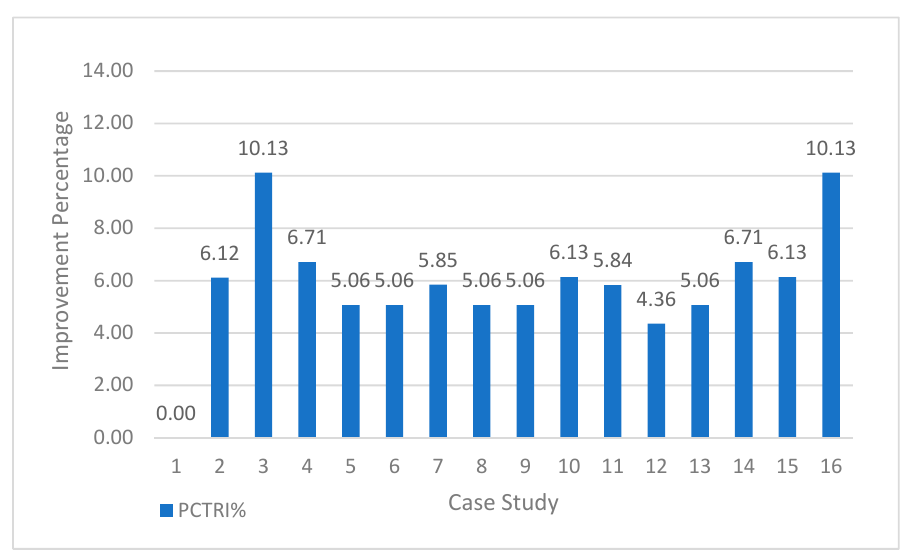
Figure 22. The results of the PCTRI % index for the solved case studies.